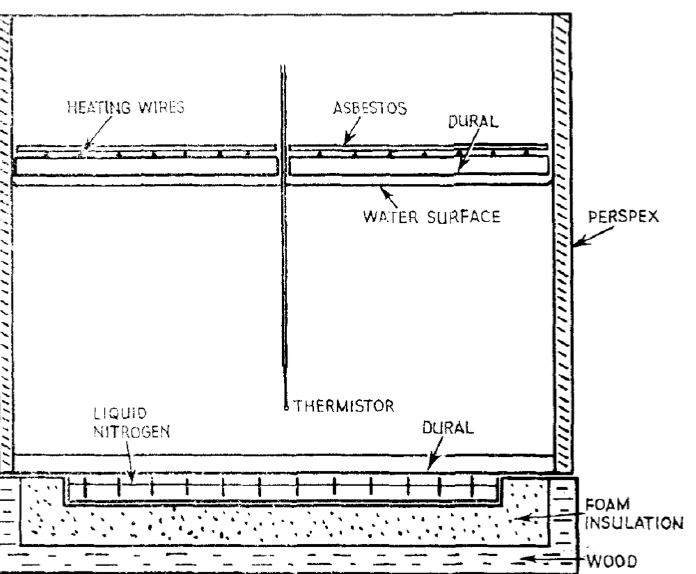
Figure 2. Experimental facility with a heated upper water layer and chilled lower layer for the formation of ice at the base of the water tank. Reproduced from [78], with permission from John Wiley & Sons,